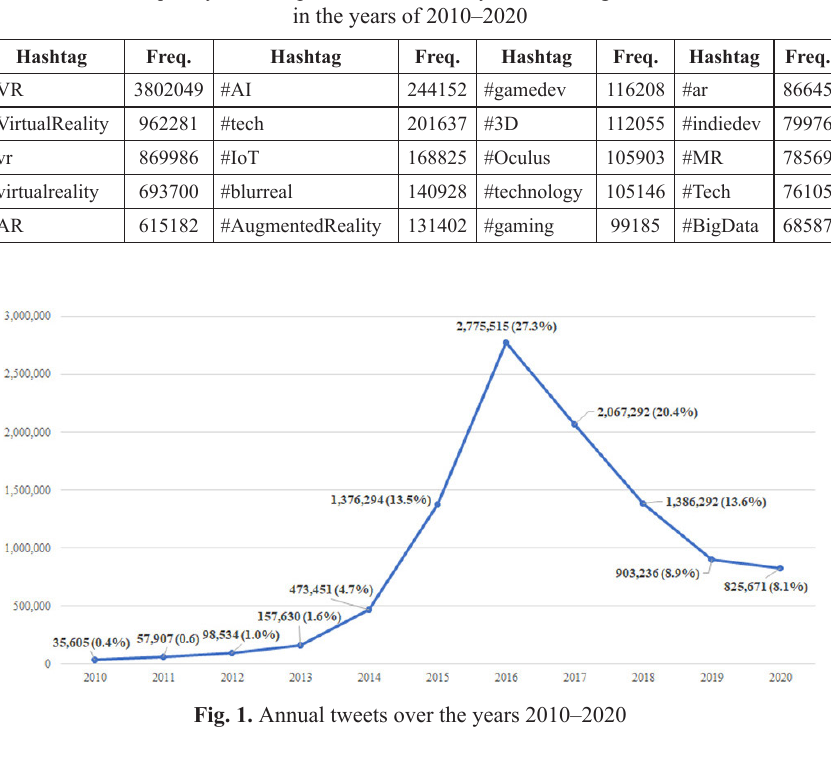
Table 2. Frequency of the top-20 most commonly used hashtags within the tweets